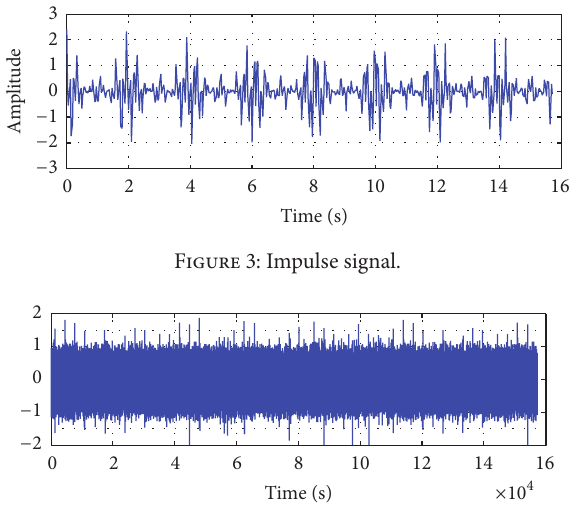
Figure 4: Vibration signal with